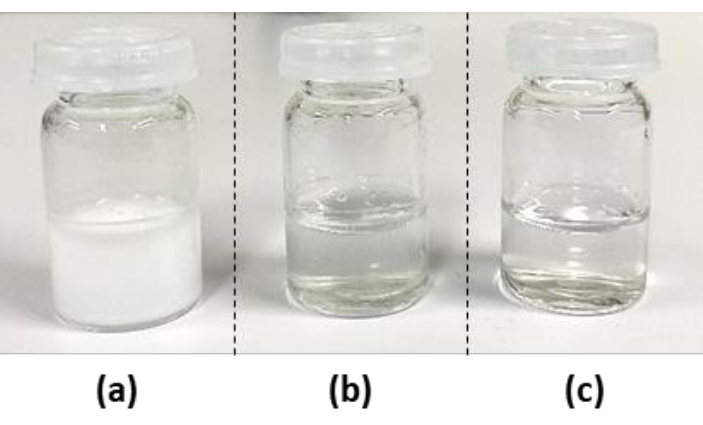
Figure 2. Carvedilol (12.3 mM) in 13 mM HCl solution ( a ) in absence of CDs or in presence of 61.5 mM ( b ) γCD or ( c ) RAMEB, after 24 h of stirring at room temperature (296 ± 2 K). 61.5 mM ( b ) γ CD or ( c ) RAMEB, after 24 h of stirring at room temperature (296 ± 2